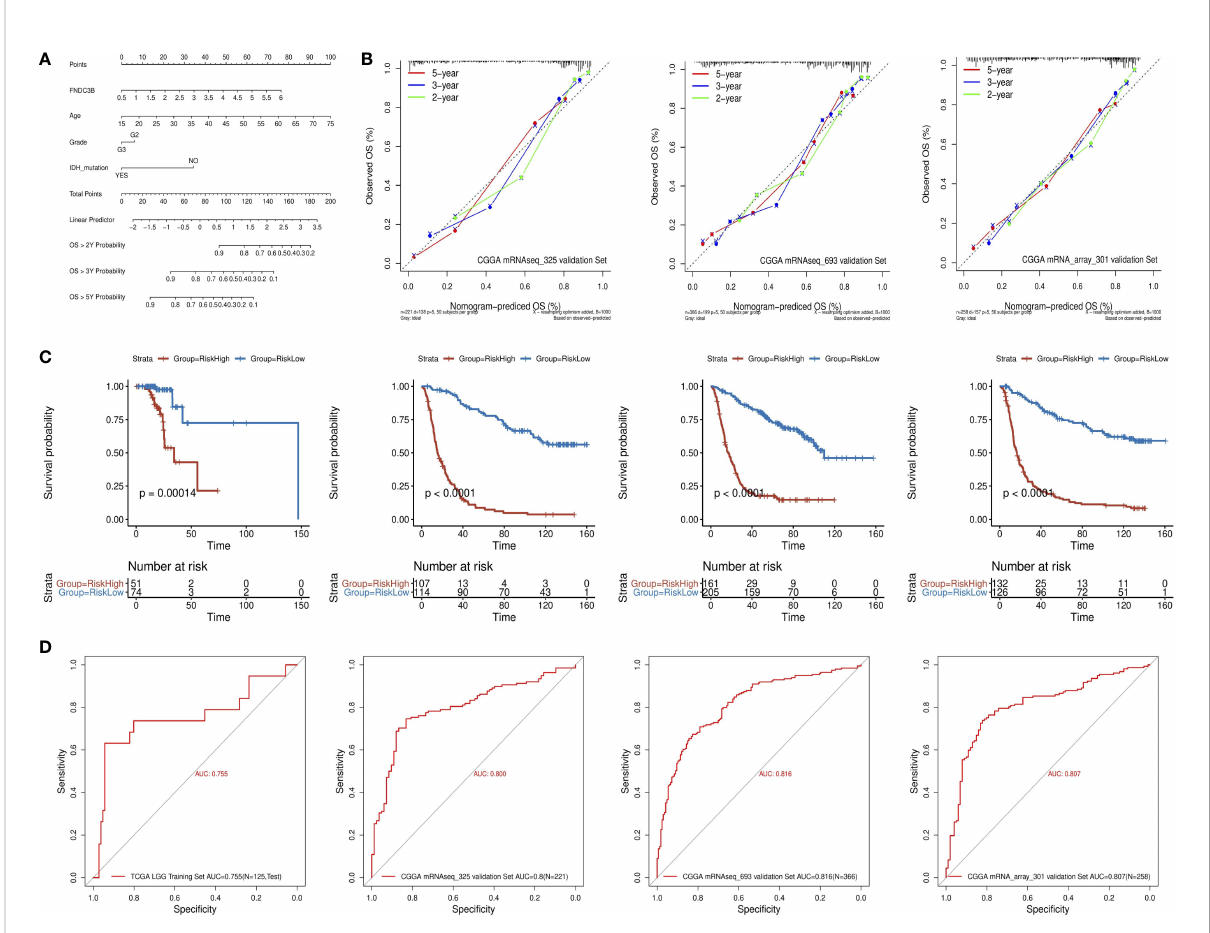
FIGURE 3 Construction and validation of the prognostic nomogram. (A) Prognostic nomogram for TCGA low-grade glioma (LGG) dataset. According to four variables (FNDC3B expression level, age, grade, and IDH status) in the model, four corresponding ‘ points ’ values can be obtained, and the ‘ total points ’ can be calculated by summing them. Therefore, the 2-/3-/5-year overall survival (OS) rate of patients can be predicted. (B) The calibration curves for predicting 2-/3-/5-year OS in the CGGA_325, CGGA_693, and CGGA_301 validation datasets, respectively. The nomogram-predicted probability of survival and actual survival are plotted on the x- and y-axes, respectively. The diagonal line represents a perfect prediction. (C) K-M curve of high-risk (red) and low-risk (blue) for TCGA low-grade glioma (LGG) training, CGGA_325, CGGA_693, and CGGA_301 validation datasets. (D) ROC curves for the risk score in the TCGA LGG training, CGGA_325, CGGA_693, and CGGA_301 validation datasets. TCGA, The Cancer Genome Atlas; CGGA, Chinese Glioma Genome